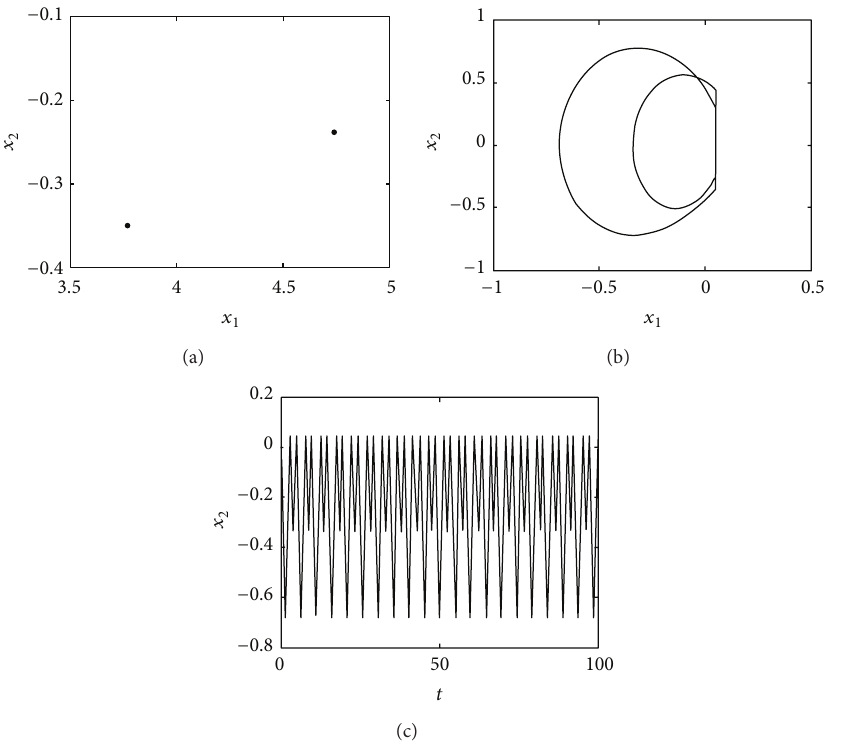
Figure 4: Poincar´e map, phase portrait, and time course diagram of the system with 𝜔 = 2.6 .